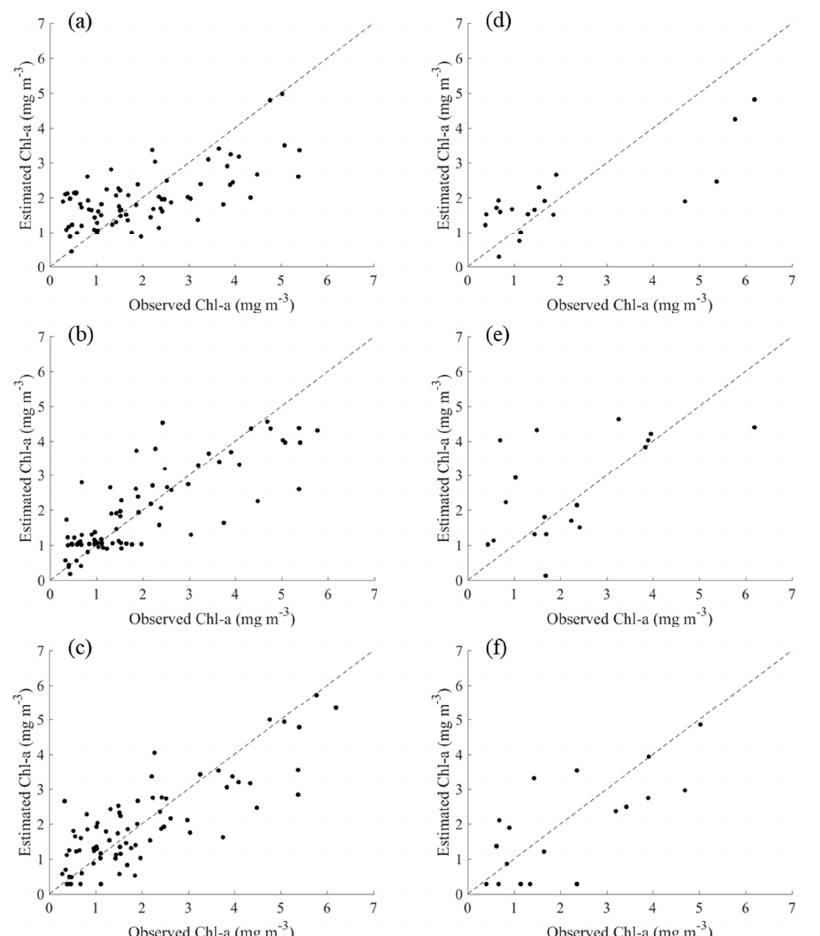
Figure 4. Scatter plots of in situ and estimated chl-a for the ANN model. ( a ) the training results for the four-band, ( d ) the validation results for the four-band, ( b ) the training results for the four-band-ratio, ( e ) the validation results for the four-band-ratio, ( c ) the training results for mixed dataset ( f ) the validation results for mixed